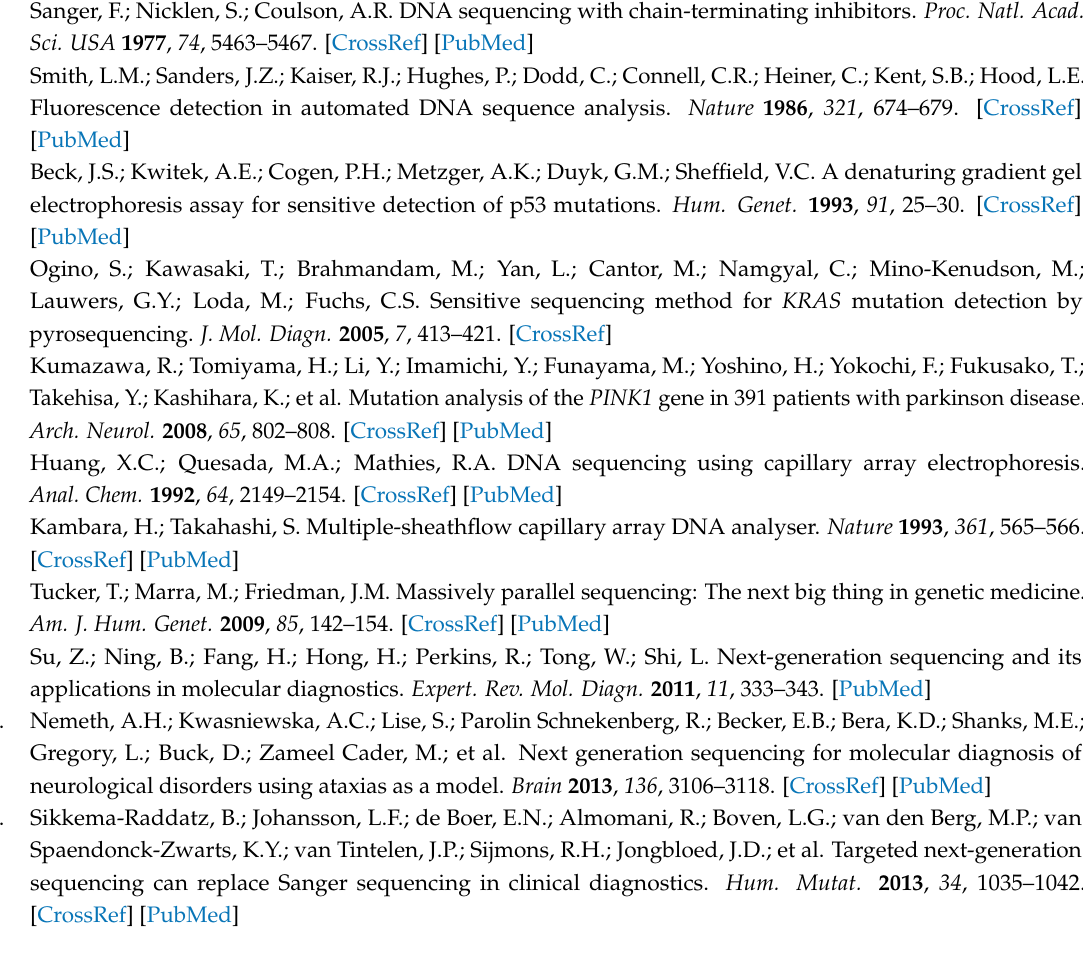
Table S1: IDP panel sequencing quality metrics; Table S2: Coverage per gene; Table S3: Amplicons with low overall performance; Table S4: List and details of undetected variants; Table S5: Examples of commercial NGS-panels. Author Contributions: M.A.-S., M.Al., H.A.Z. and Z.A.-H. contributed with patients recruitment, diagnosis